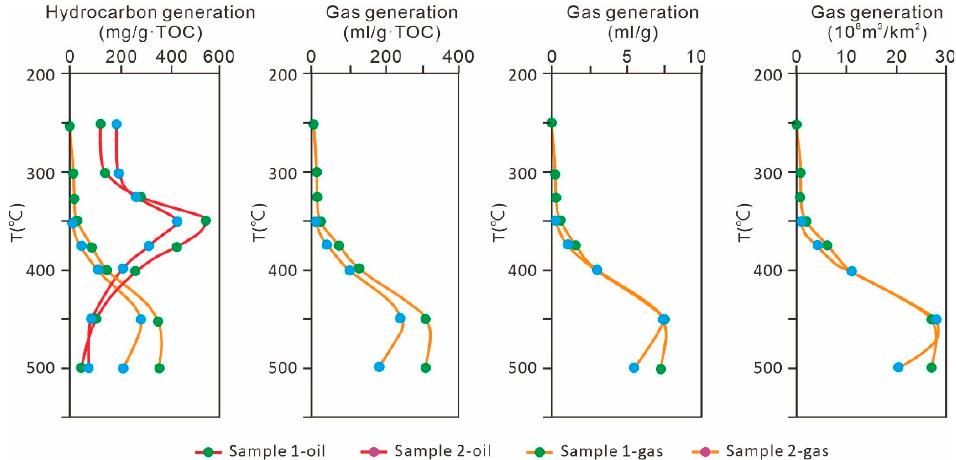
Figure 6. Hydrocarbon producing rate and gas generation intensity of the Fengcheng Formation. The vitrinite reflectance (R o ) of source rock samples at each simulated temperature point was measured during the hydrocarbon generation simulation experiment, and the R o corresponding to 425 °C was about 1.45%. The relationship between the gas generation intensity and burial depth of source rock was deduced according to the relationship be ‐ tween R o and burial depth.